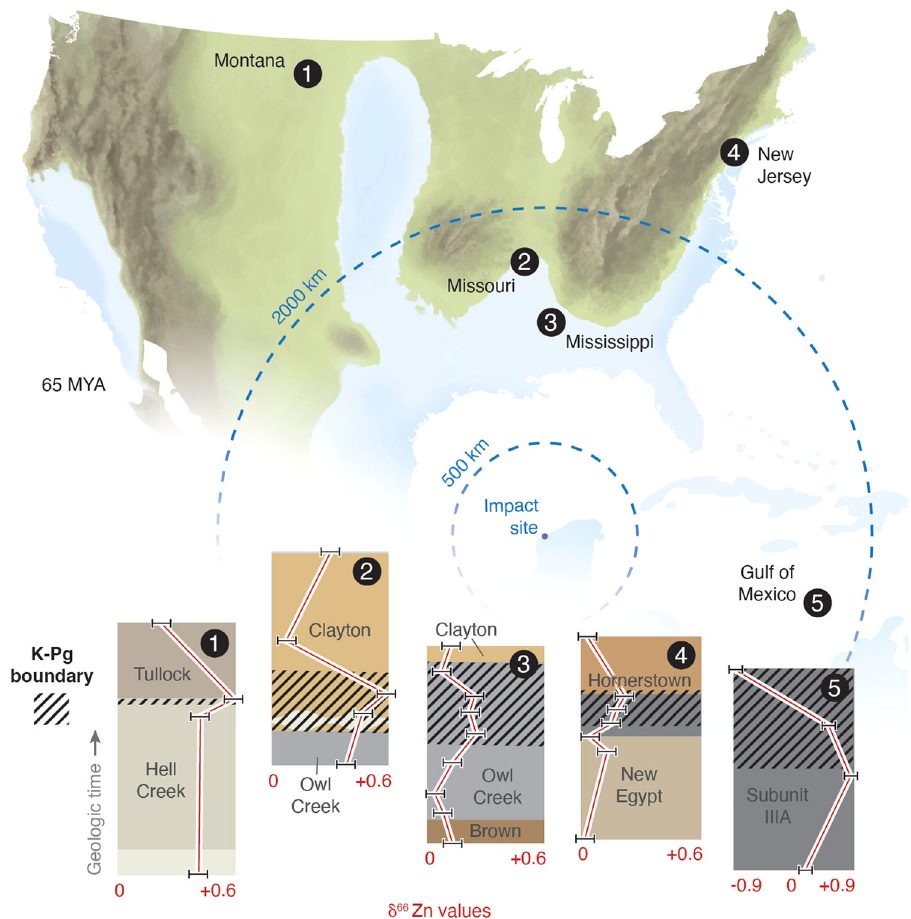
Fig. 1 Paleo-depositional map of North America during the end of the Cretaceous. Approximate locations of sampling sites plotted with the Zn isotope variations seen in the different stratigraphic intervals (formations labeled in cartoon stratigraphic column). Errors of the Zn isotopes are 0.05 per mil and are not signi fi cantly larger than the red line with white boarders. The cross-hatched area indicates the layers that contain the K – Pg